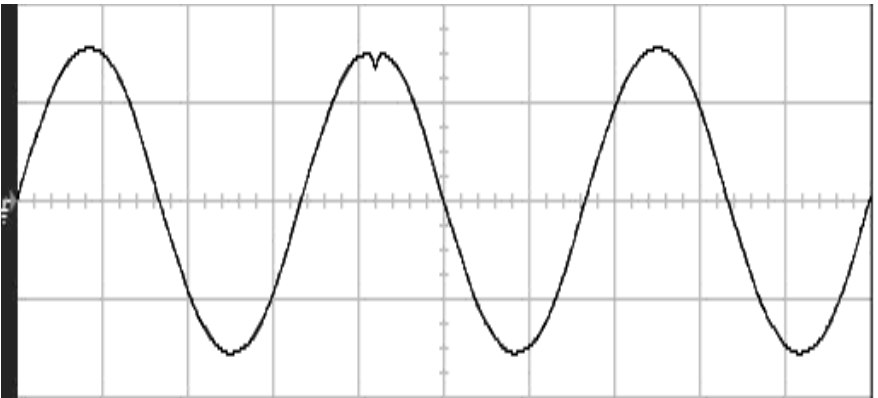
Figure 11. Experimental output voltage with the proposed controller under step changing in resistive load (vertical: 100 V/div; horizontal: 5 ms/div).